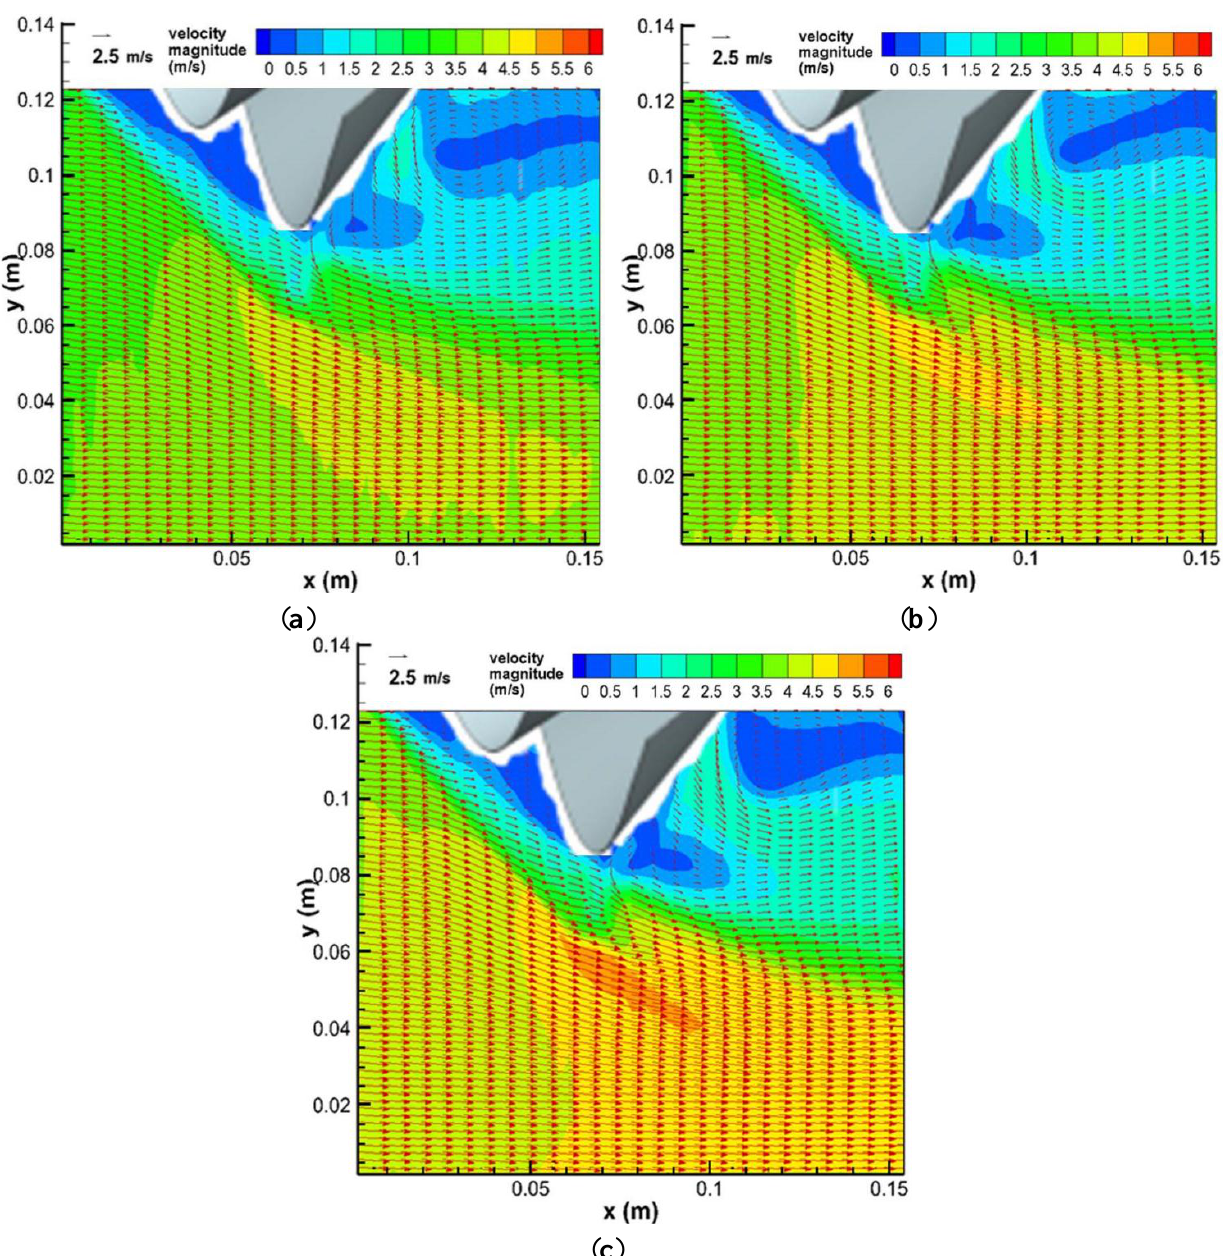
Figure 11. Ensemble averaged velocity fields obtained by the PIV